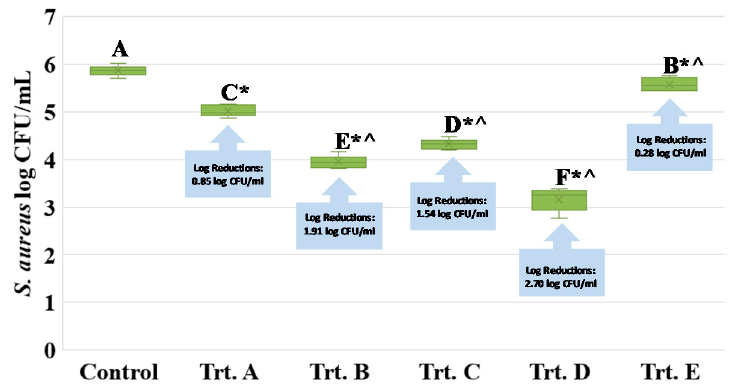
Figure 7. Inactivation of S. aureus by elevated hydrostatic pressure in presence of bacteriocin and bactericidal compounds and mild heat. Control: Untreated control (0 MPa at 4 °C for 3 min); Trt. A: Treated control (650 MPa at 4 °C for 3 min). This treatment is currently the industry standard for